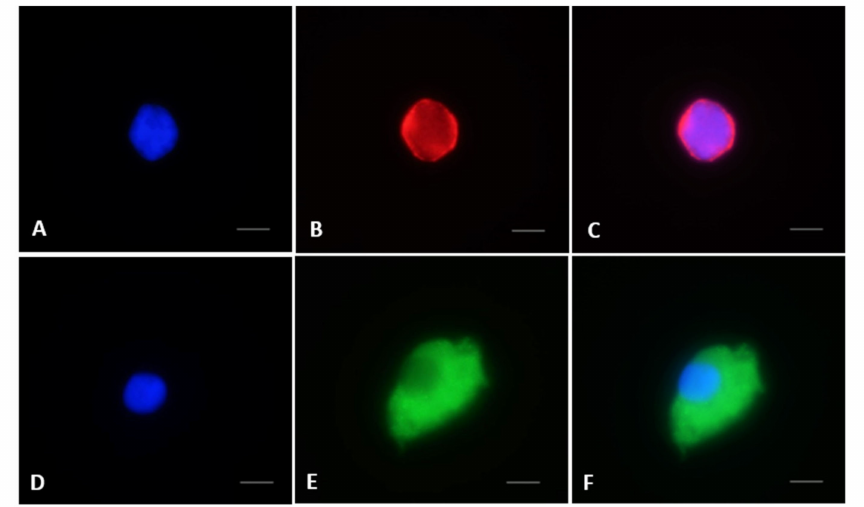
Figure 8. Immunostaining of Oct4 and Boule in testicular cells from black-footed ferrets. ( A ) Nucleus stained with Hoechst, ( B ) presence of Oct4 in the nucleus, ( C ) merged image, ( D ) nucleus stained with Hoechst, ( E ) presence of Boule in the cytoplasm, ( F ) merged image. Bar = 5 µ